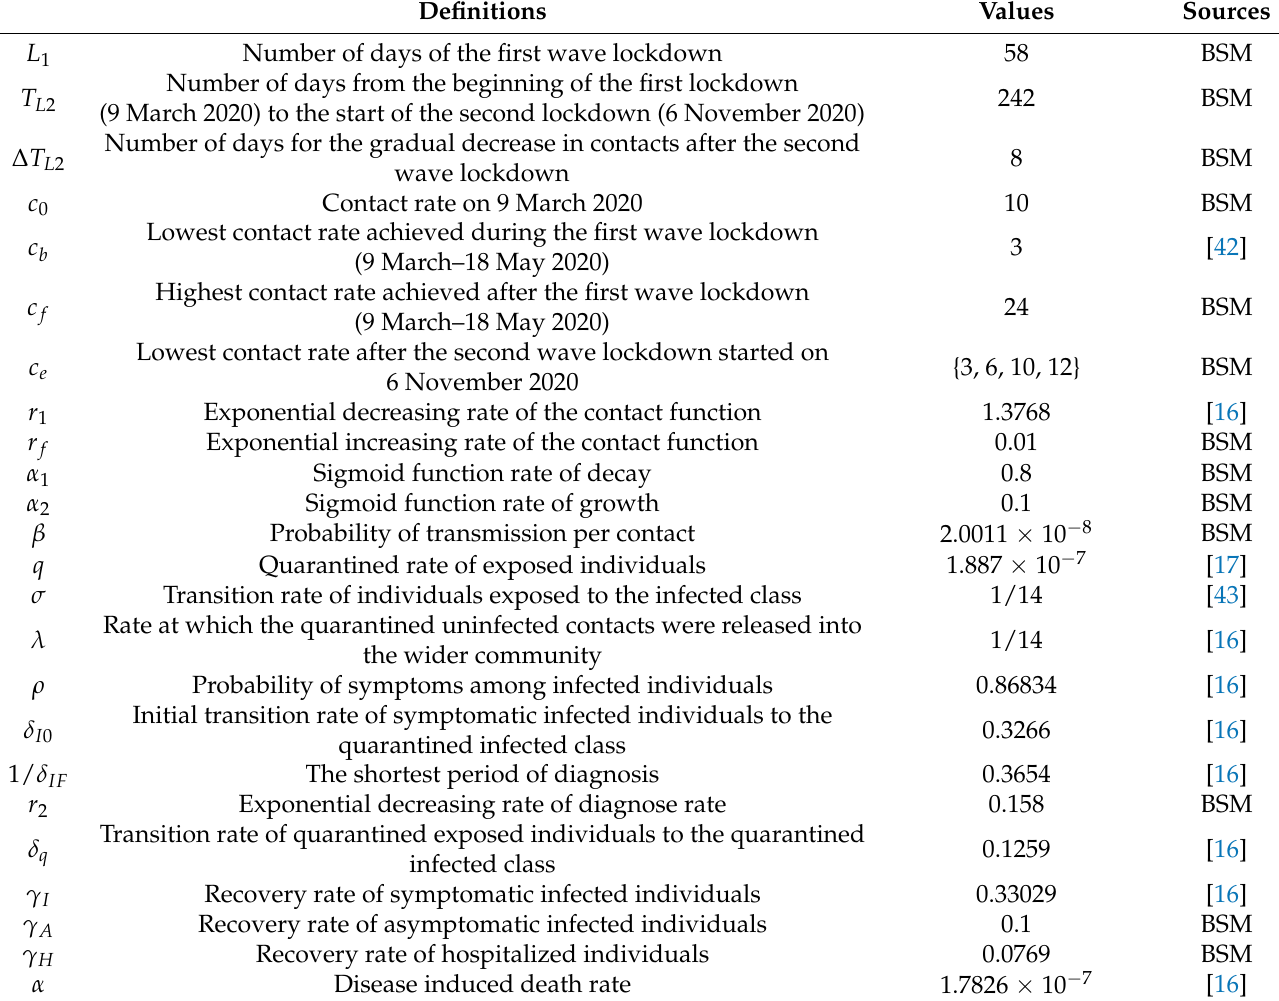
Table A2. Hyper-parameters used in the BSM differential